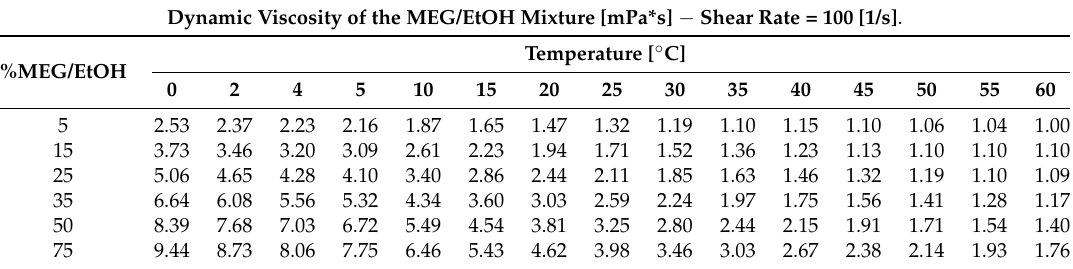
Table 5. Tests results for the dynamic viscosity of the MEG/EtOH Mixture − Shear rate = 100